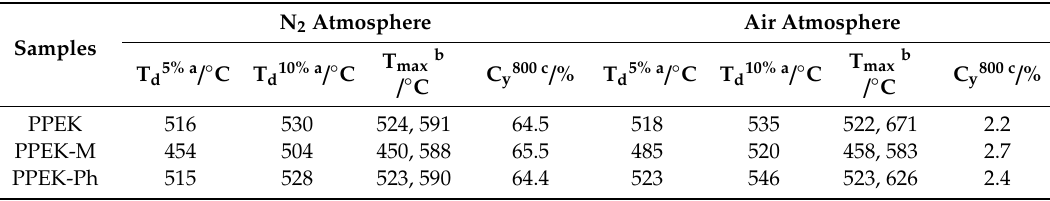
Figure 4. TGA and Differential thermal gravity(DTG) curves of the PPEKs resins in N 2 ( left ) and air ( right ). Table 3. Thermal properties of PPEKs resins according to TGA